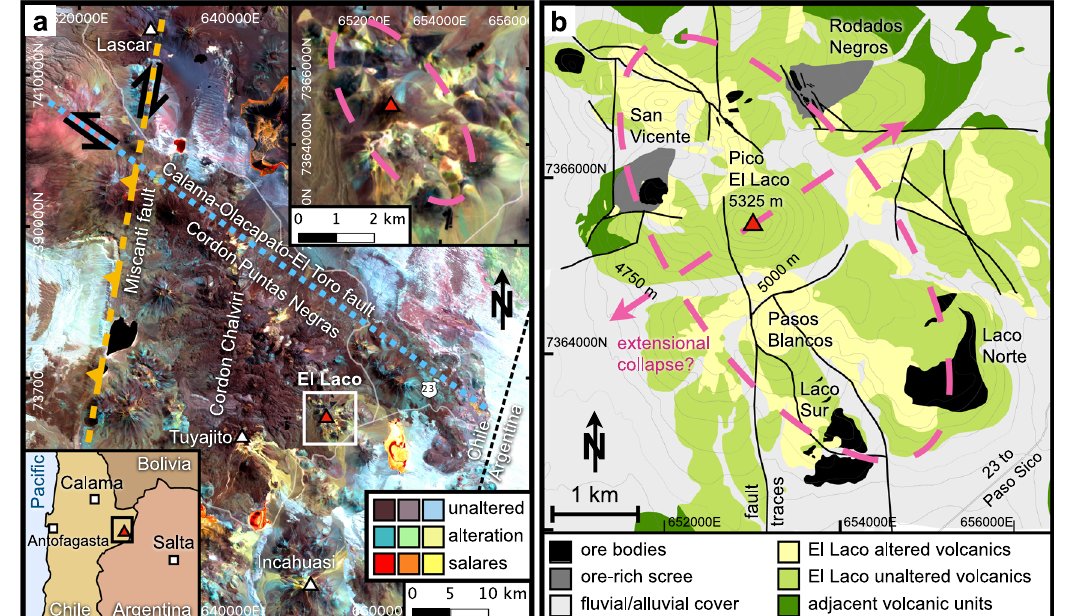
Fig. 1 | Regional tectonic and localgeologiccontext ofElLaco volcaniccentre, Northern Chile. a Sentinel-2 infrared pseudo-colour image (RGB: bands 8, 11, 12) highlights areas of unaltered volcanics and alluvial cover (brown-purple-lavender), altered volcanics (teal-light green-beige), and salares (red-orange-yellow). Other volcanoes in the vicinity are labelled by white triangles. NS-trending right-lateral transpressive Miscanti fault (amber dashed) and NW-SE-trending left-lateral Calama-Olacapato-El Toro fault (light blue dotted) dominate regional tectonics;